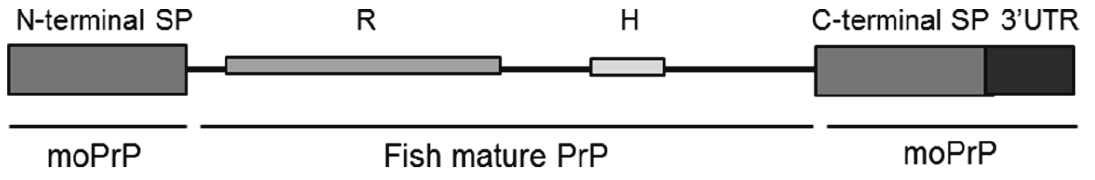
Figure 2. Chimeric mouse-fish constructs. Schematic illustration of the chimeric recombinant protein constructs introduced into the neuroblastoma cells. SP, signal peptide; R, repeat region; H, hydrophobic domain; 3'UTR, 3' untranslated region; moPrP, mouse